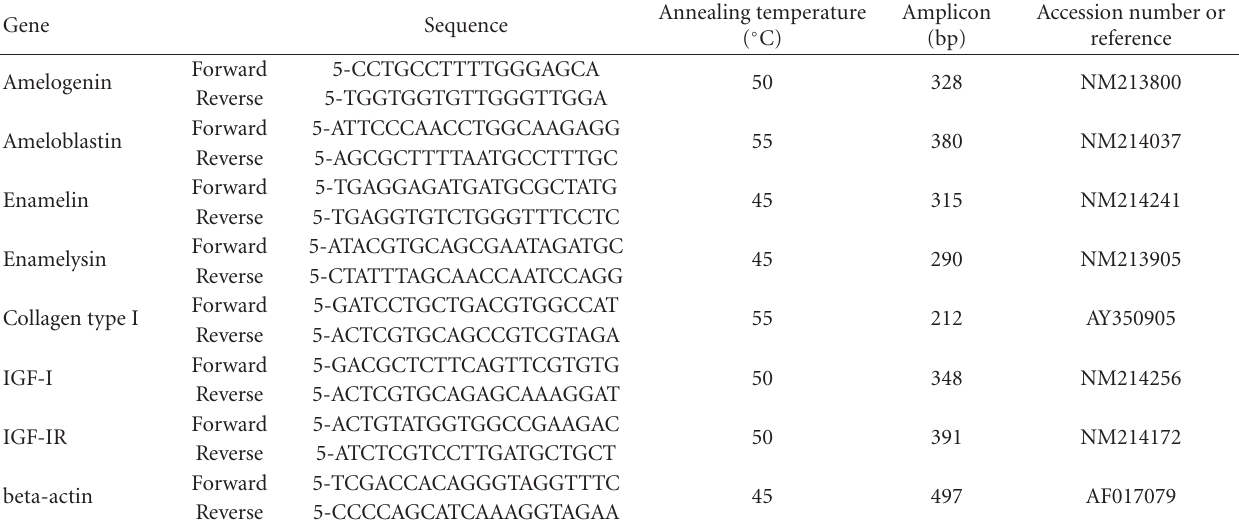
Table 1: Sequence of primer pairs used for semiquantitative